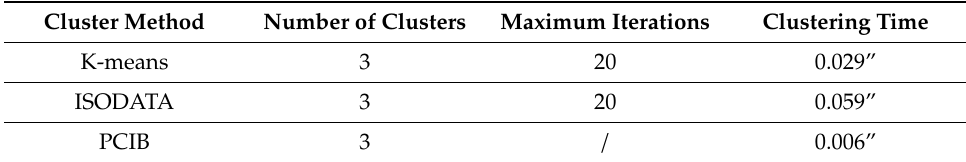
Table 9. Clustering time comparison of K-means, ISODATA and